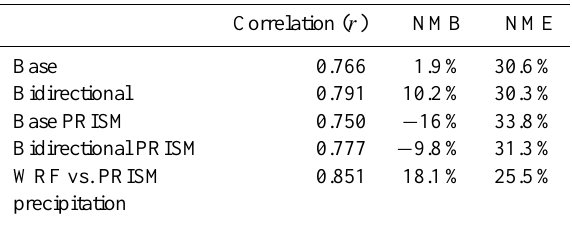
Table 2. Annual base and bidirectional Pearson’s correlation coef- ficient, NMB and NME compared to annual NADP